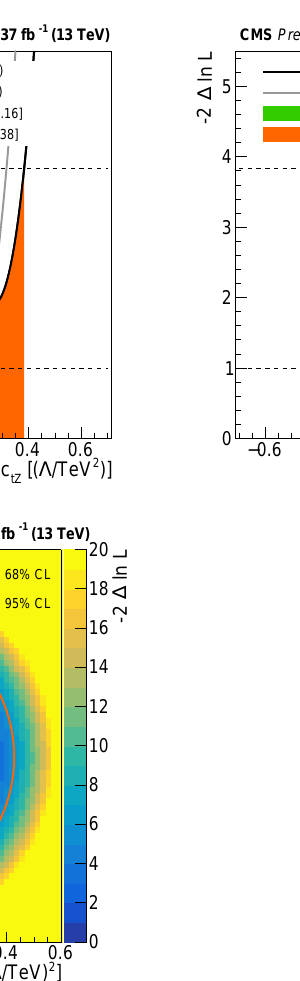
Figure 24. Best fit values for the explored EFT Wilson coefficients by CMS in the single − lepton channel [47]. Both the 1D and 2D scans are